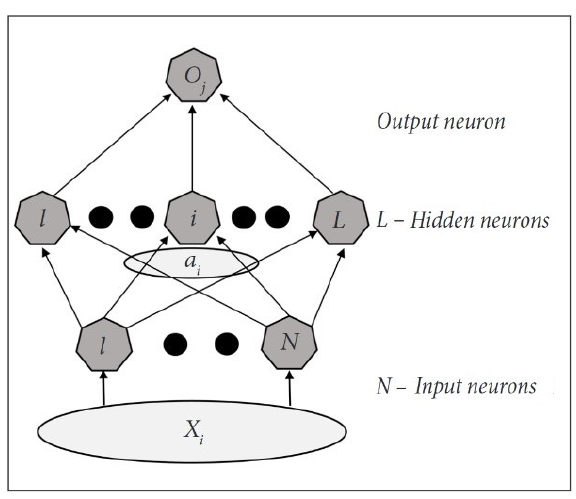
Figure 4. Example of a single layer feedforward neural network (SLFNN) [55,59].